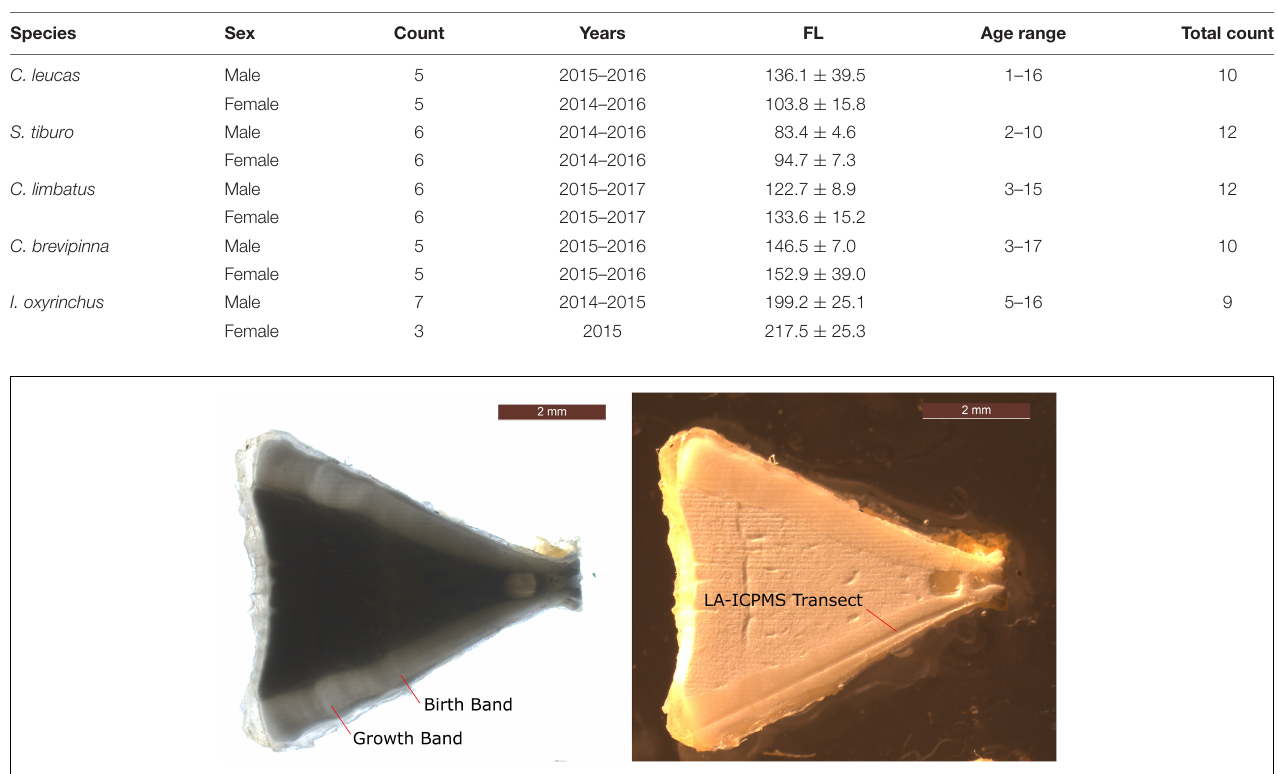
TABLE 1 | Sample sizes (Count) of individuals analyzed with LA-ICP-MS by species and sex, with years of collection, average fork length (FL) ± 1 SD in cm, and range of ages in years (sexes pooled). Species